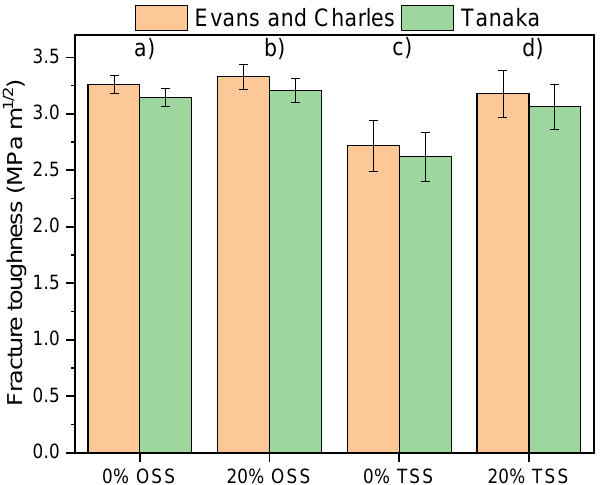
Figure 6. The calculated fracture toughness according to median crack models for: (a) OSS/0 dwb. % WAP; (b) OSS/20 dwb. % WAP; (c) TSS/0 dwb. % WAP; (d) TSS/20 dwb. % WAP.